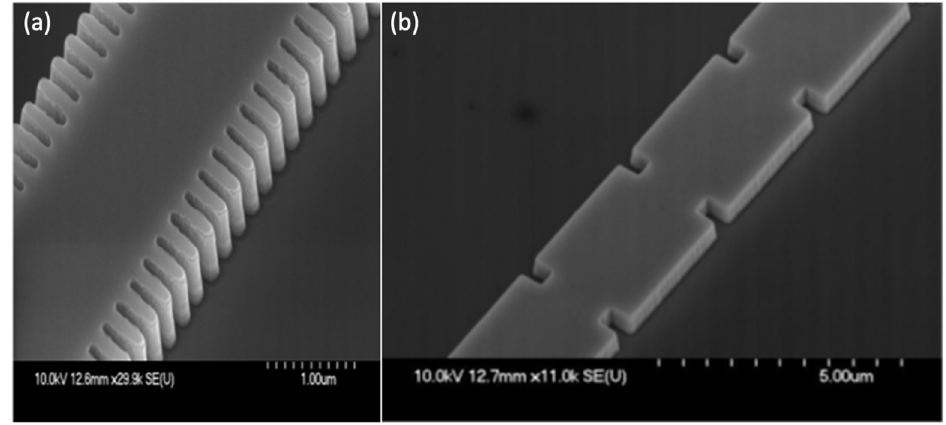
Figure 8. ( a ) SEM image of the as etched third-order DFB grating and ( b ) SEM image of the as-etched 39th DFB-order grating. 39th DFB-order